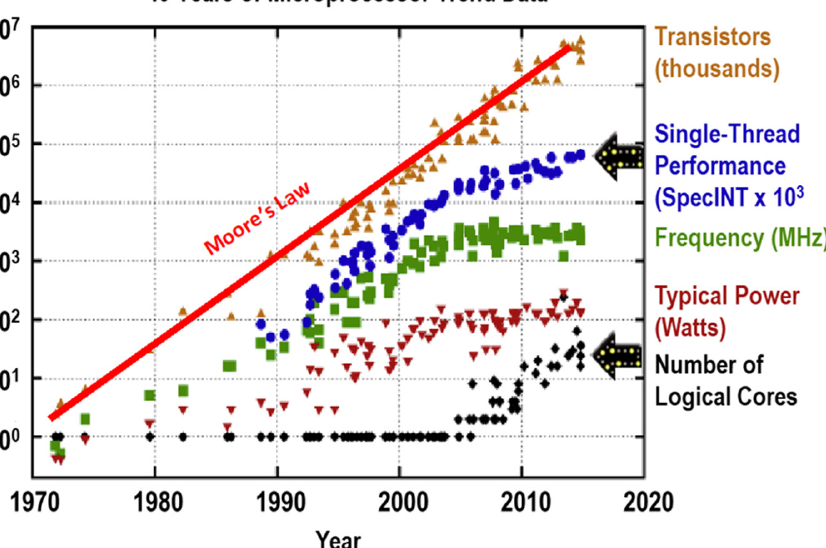
Figure 1. Development of multicore architecture in the first decade of this century (source, accessed on 1 July 2016: https://developer.ibm.com/articles/j-java-streams-4-brian-goetz/).